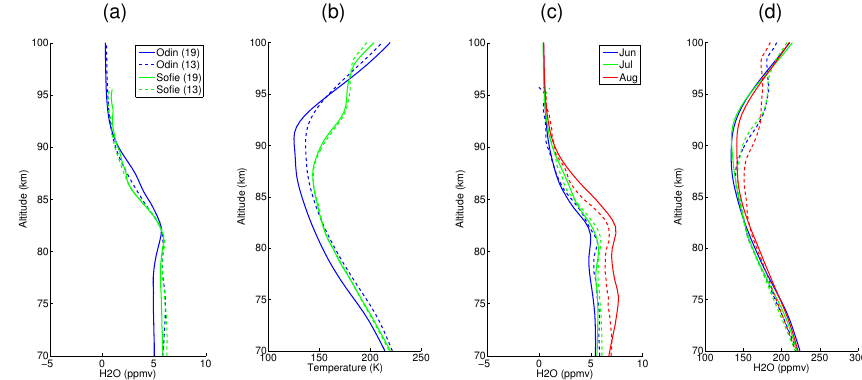
Figure 13. Mean water vapour (a) and temperature (b) profiles from SMR (blue) and collocated SOFIE measurements (green). The mea- surements where SMR is operating in frequency mode 19/13 are given by the dashed and solid lines respectively. Mean water vapour (c) and temperature (d) profiles from SMR (solid) and collocated SOFIE measurements (dashed) for June (blue), July (green) and August (red). For (c) and (d) only measurements using frequency mode 13 are